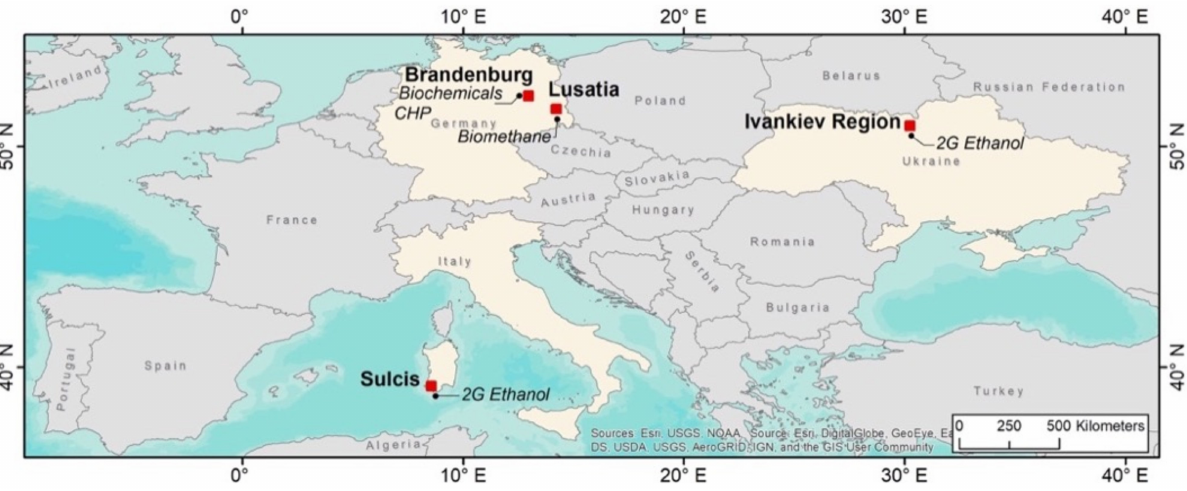
Figure 1. Potential bioenergy sites identified for the analysis. Table 3. Total hectares and Capital (CAPEX) and operation (OPEX) expenditures of the selected